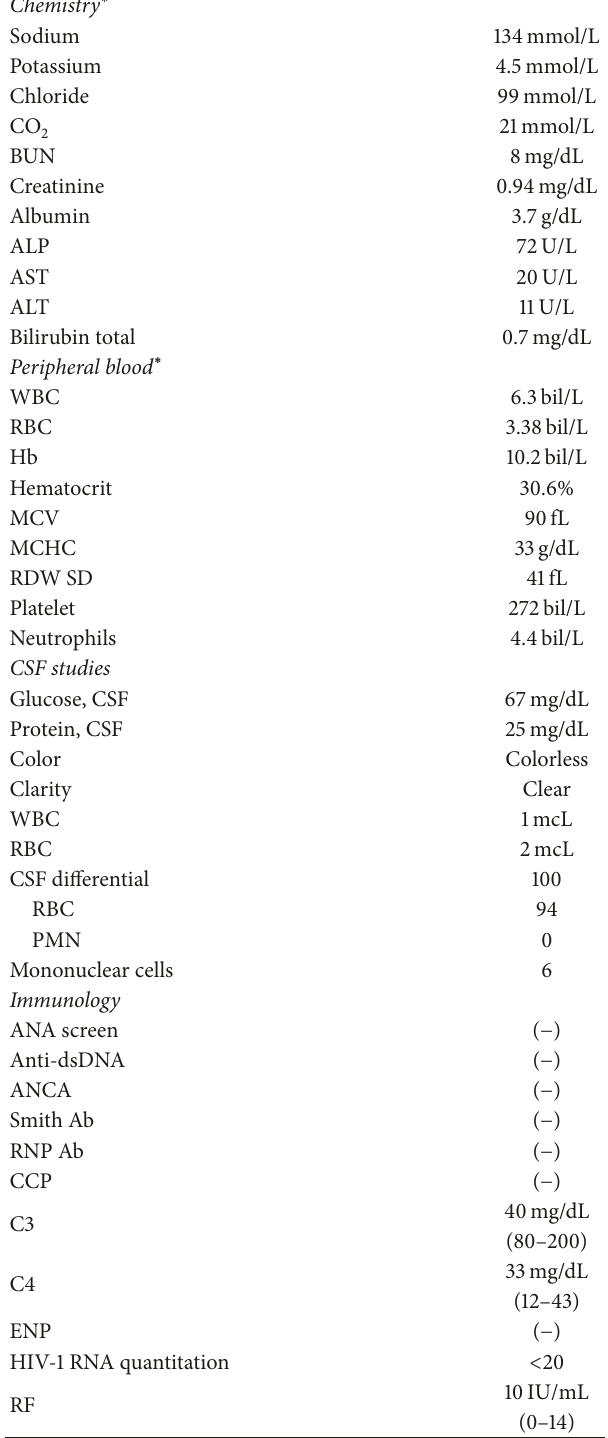
Table 1: Laboratory findings during admission. ANA: antinu- clear antibody, Anti-dsDNA: Anti-Double Stranded DNA, ANCA: antineutrophil cytoplasmic antibody, Ab: antibody, C: complement, RNP: ribonucleoprotein, CCP: anticyclic citrullinated peptide, ENP: extractable nuclear antibodies, RF: rheumatoid Factor, CG: